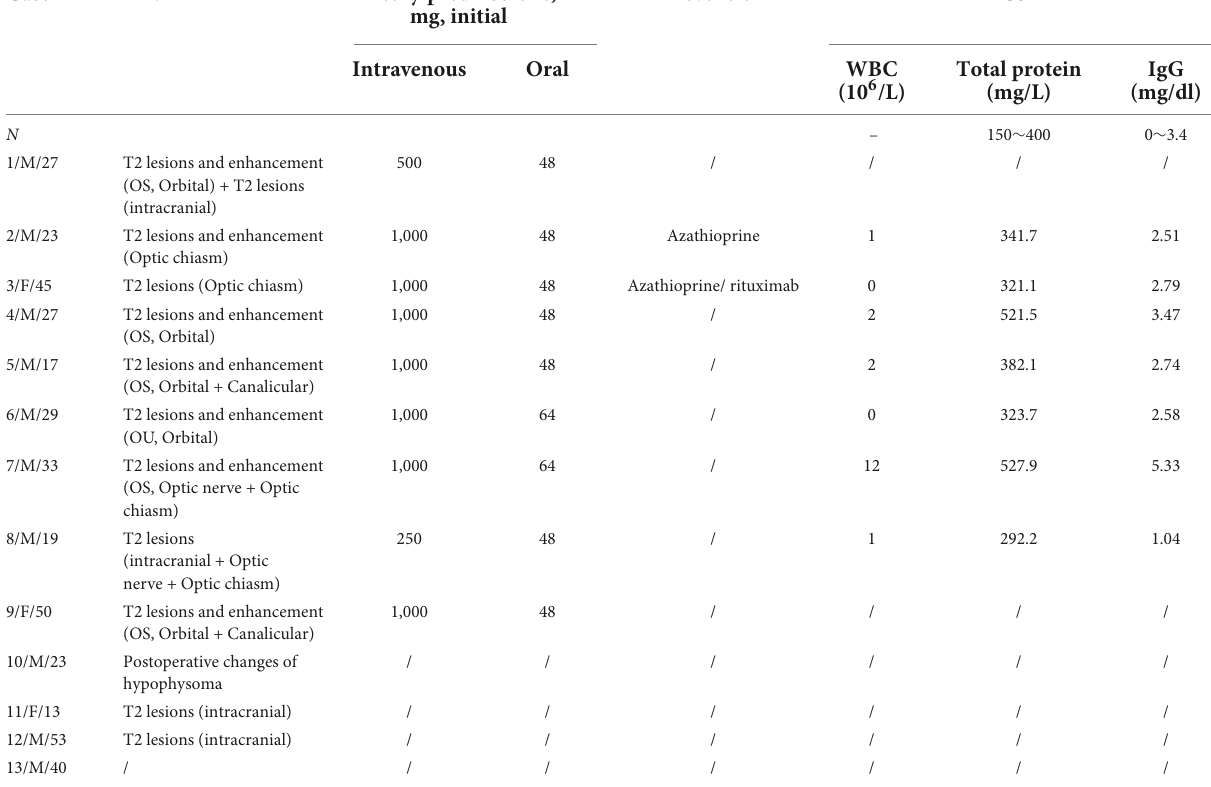
FIGURE1 This shows the images evidence and changes in the patients with Leber’s hereditary optic neuropathy (LHON). Color fundus photographs (A,F) demonstrate temporal optic nerve pallor OS (F) . Humphrey visual field (VF) testing demonstrates a dense superior central scotoma OD (B,C) and a central scotoma with a superior arcuate defect OS (G,H) , having mean deviations (MD) of –13.54 and –12.73, respectively. SD-OCT imaging of the peripapillary nerve fiber layer (pRNFL) (D,I) showed diffuse thinning of the left eye (I) . Spectral-domain optic coherence tomography